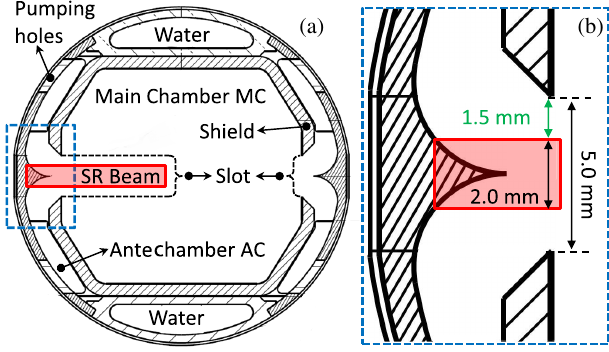
FIG. 8. (a) Cross section of the FCC-hh BS design in which analogy the samples presented in this work were manufactured. The blue dashed square represents the portion of the cross section presented in (b). The red square represents the area of the SR beam. (b) Magnification of the sample ’ s slot aperture of the FCC-hh BS. The red square represents the area of the SR